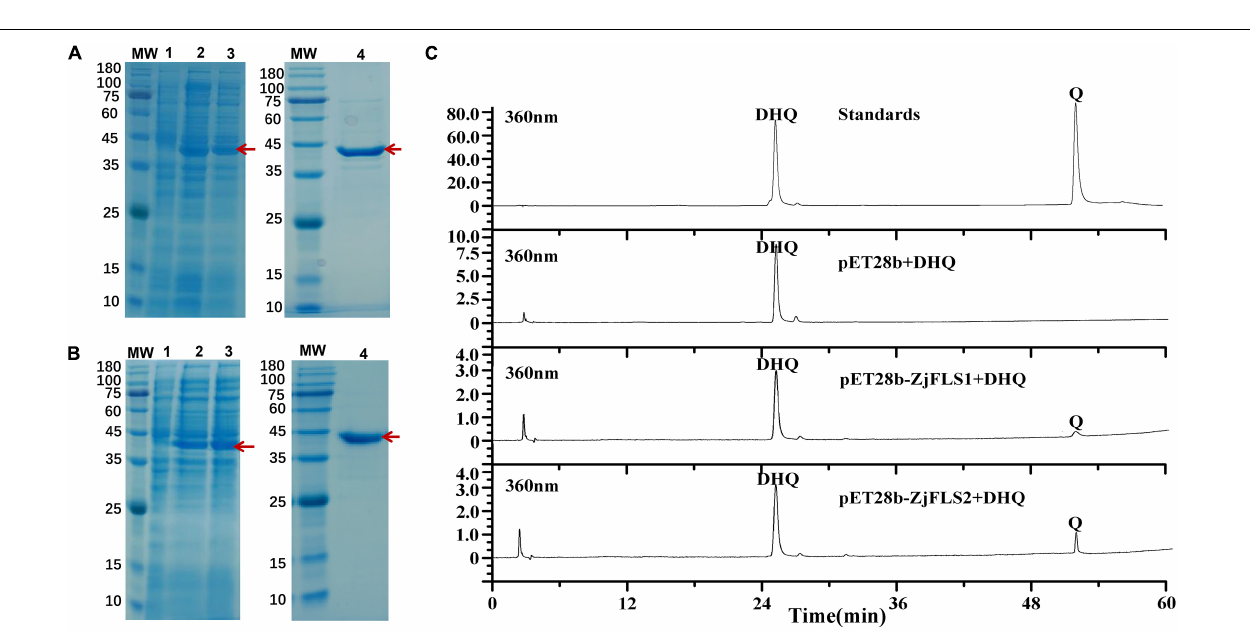
Frontiers in Nutrition |